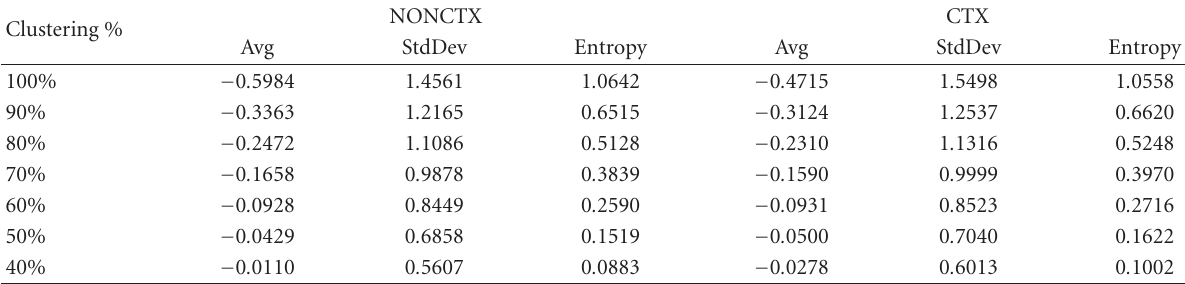
Table 1. Characteristics of substitution scores.